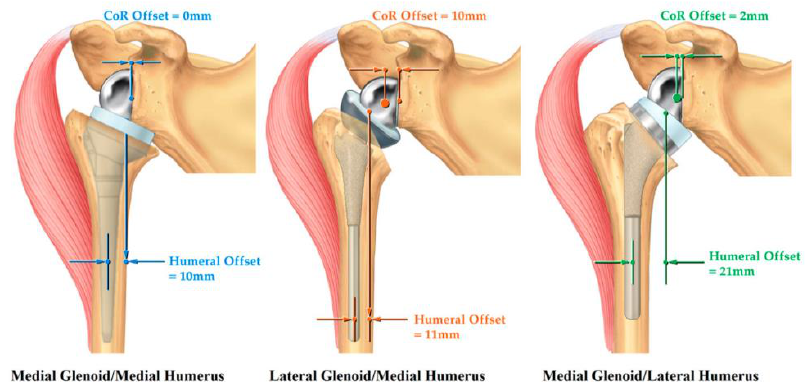
Figure 3. Classification system for RTSA described by Routman et al. From left to right: Medial glenoid/Medial Humerus design (Original Grammont design); Lateral Glenoid/Medial Humerus design (inlay humerus with lateralized glenoid); Medial Glenoid/Lateral Humerus (Onlay humerus with medialized glenoid). Lateralized humerus design (>15 mm humeral offset); Lateralized glenoid design (>5 mm COR offset) COR: center of rotation [20].